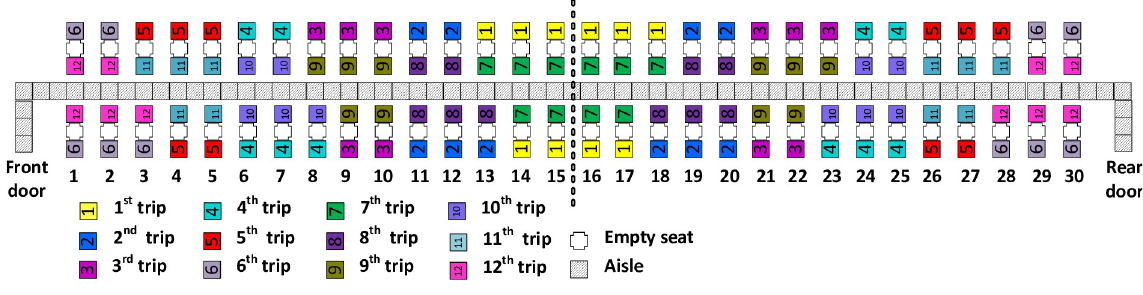
Fig 2. WilMA—Back-to-front boarding